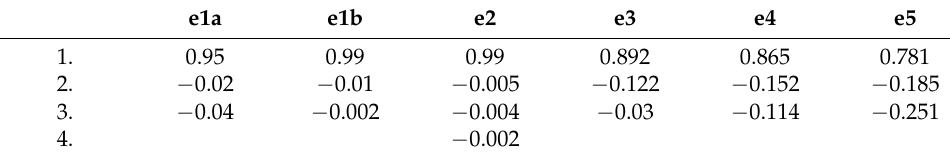
Table 2. Observation coefficients (hxx,